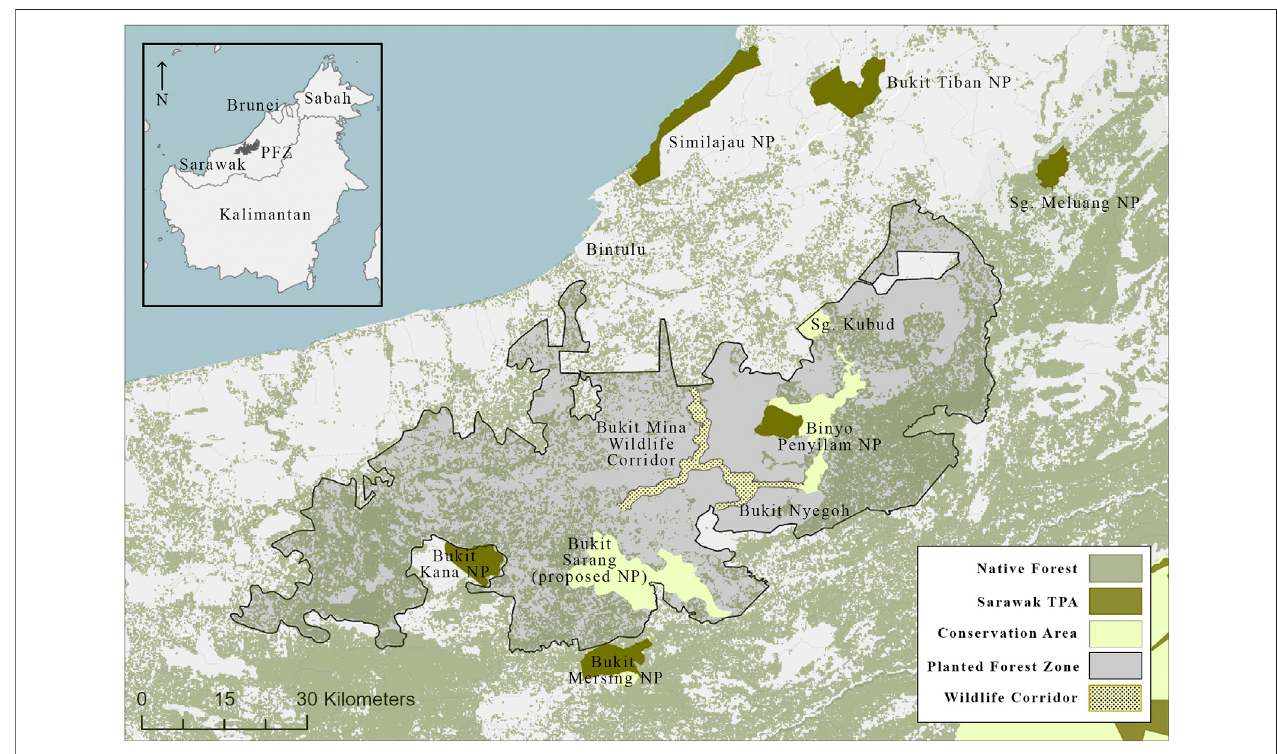
FIGURE 1 | Map of Sarawak Planted Forests and surrounding landscape. The area indicated as native forest is forest that was previously logged (30 + years ago). TPA, Totally Protected Area; SPF, Sarawak Planted Forests. Areas labelled as Conservation Area are areas within SPF that are designated for conservation but have no formal protection